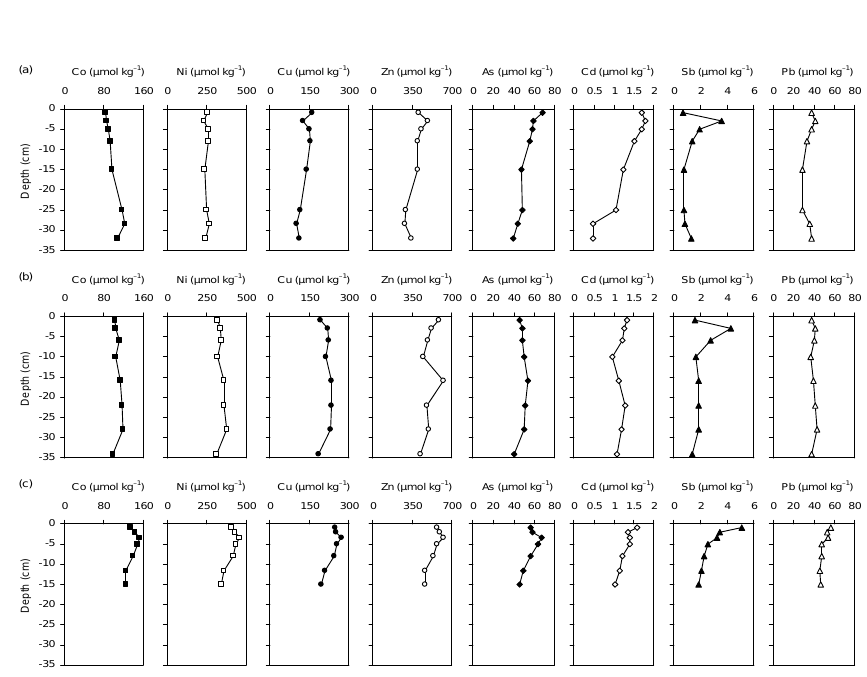
Fig. 6. Concentration–depth profiles of trace metals and metalloids in the sediments of (a) Lake Shirokoe (3rd stage), (b) Lake Yamsovey (4th stage), and (c) Lake Khasyrei (5th